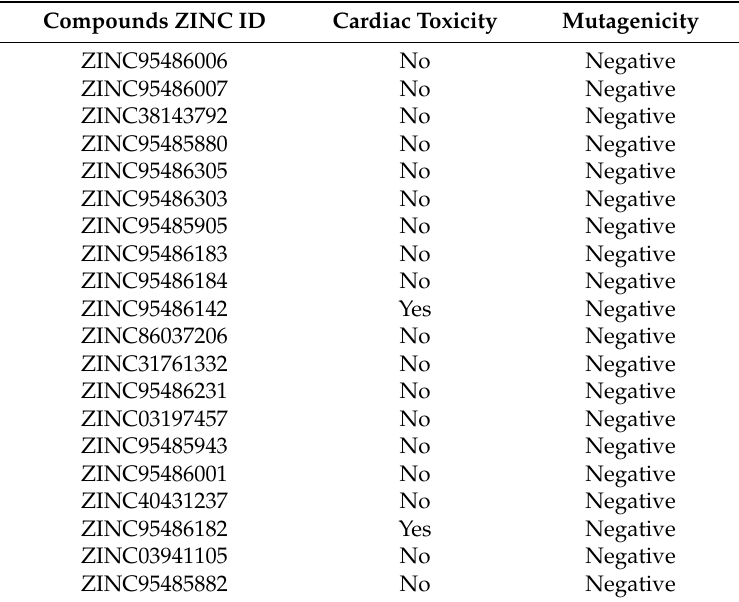
Table 5. Cardiac Toxicity and Mutagenicity tests. Cardiac toxicity was based on the hERG model, which predicts whether the compound blocks the hERG K+ channel or not. A “yes” indicate a compound that has the likelihood to block a channel and a “no” indicate otherwise and “negative” means compound might not cause any mutation in host genes.